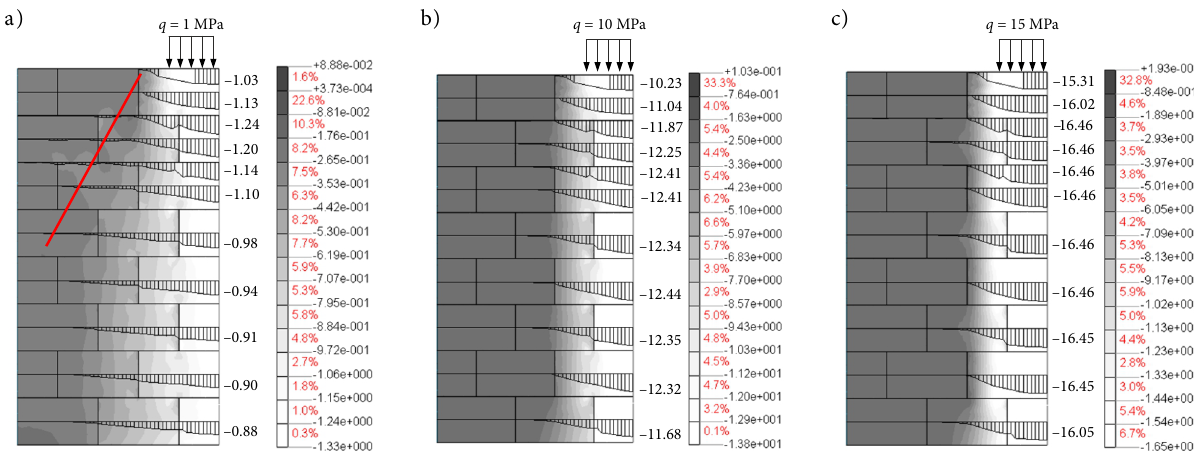
Figure 7. Distribution of main compressive stresses: a) at load of 1 MPa; b) at load of 10 MPa; c) at load of